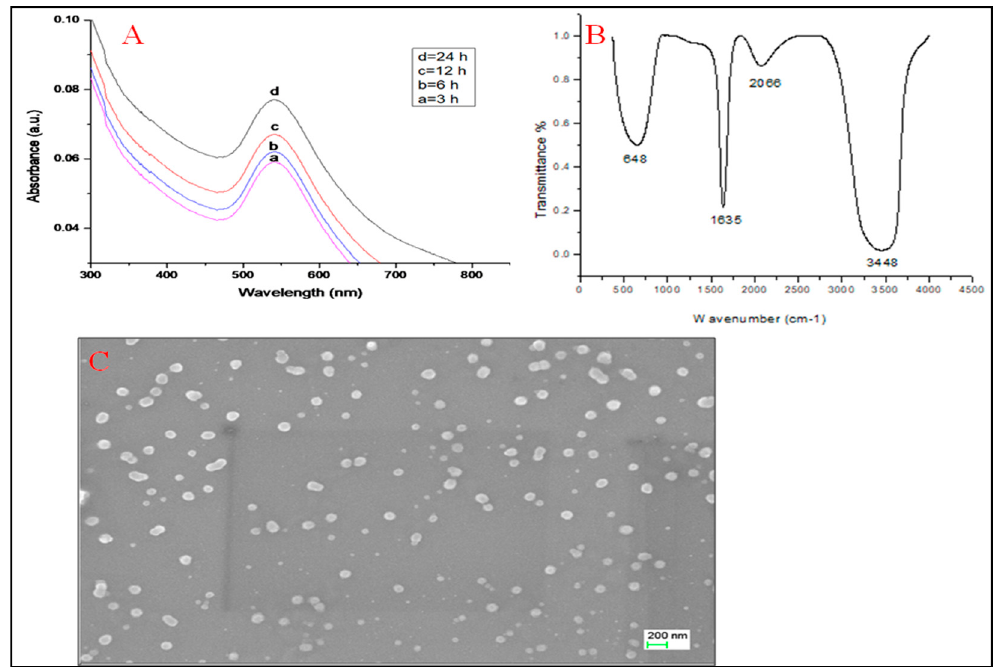
Figure 1. Characterization of synthesized gold nanoparticles. ( A ) Ultraviolet-visible (UV-Vis) and ( B ) Fourier-transform infrared (FTIR) spectra of green-synthesized gold nanoparticles (AuNPs). ( C ) Scanning electron microscopy (SEM) analysis showing different nanoparticles scattered without agglomeration.